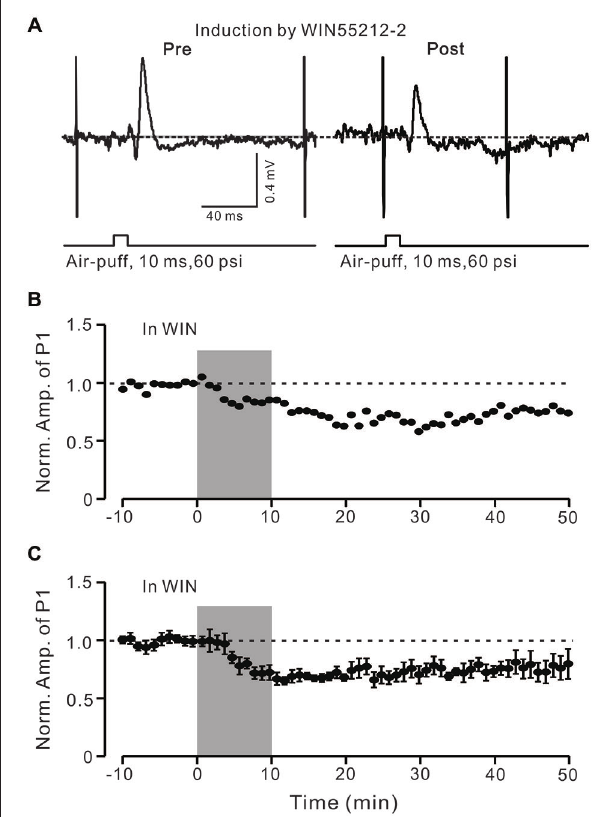
FIGURE 7 | LTD of GABAergic transmission at PCs was induced by a CB1 receptor agonist . (A) Representative cell-attached recording traces showing air-puff stimulation (10 ms, 60 psi)-evoked responses in a cerebellar PC before (left) and after application of CB1 agonist WIN55212-2 (5 µ M; 10 min). (B) Time course of normalized amplitude of P1 (shown in A ) before and after application of CB1 agonist WIN55212-2 (5 µ M; 10 min; shadow). (C) Pooled data showing the average normalized amplitude of P1 before and after application of CB1 agonist WIN55212-2 (5 µ M; 10 min; shadow; n = 7). Note that application of CB1 agonist WIN55212-2 for 10 min induced LTD of P1. Data points are mean ±